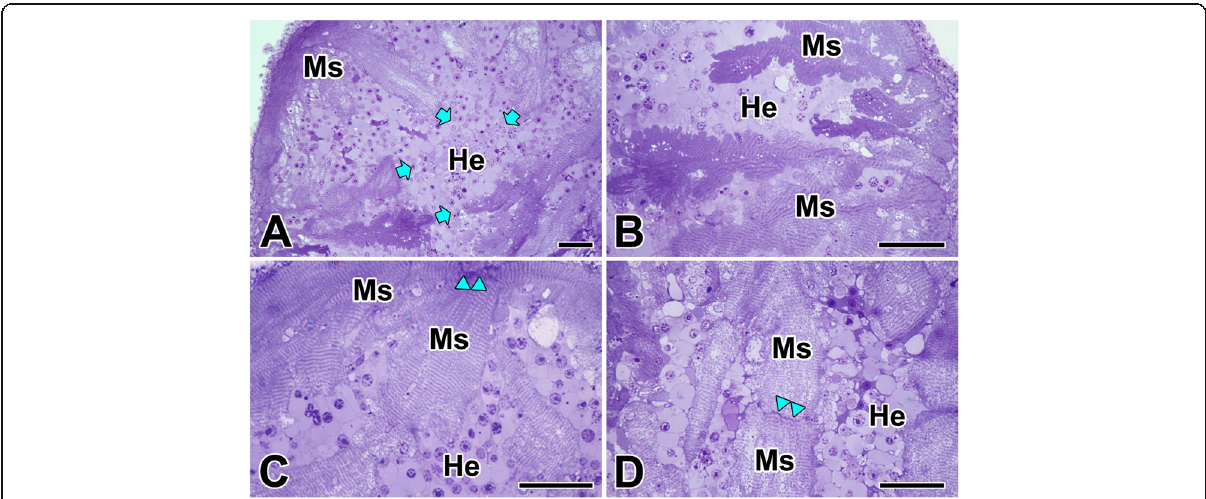
Fig. 1 Photo micrographs of toluidine blue-stained plastic-embedded sections of the heart in the spider, L. mactans. a , b : Spider heart is not divided into chambers, but consists of a simple muscular tube. Arrows indicate muscle fibers (Ms) surrounding numerous hemocytes (He). c , d : Cardiac muscle fibers are striated, and tightly connected to other cells by the intercalated disc (Cd). Double arrowheads indicate the location of intercalated discs between adjacent cardiac muscle fibers. All scale bar indicates 50 μ